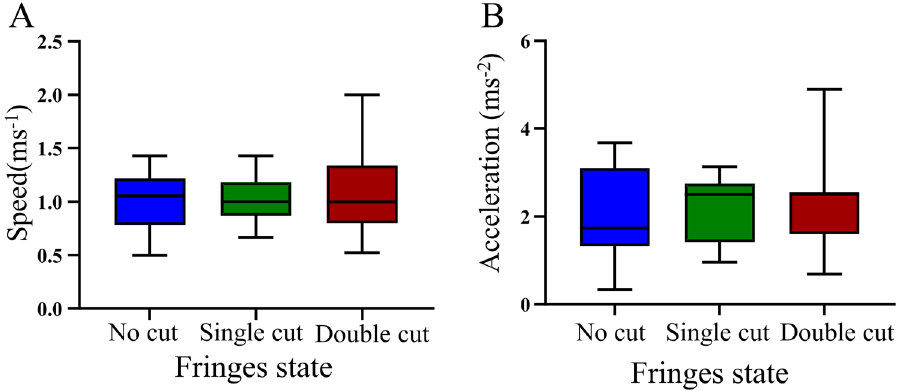
Figure 3. Maximum sprint speed ( A ) and maximum acceleration ( B ) over a sand substrate of Phrynocephalus mystaceus under different states. Note Different letters indicate significant differences at the P < 0.05